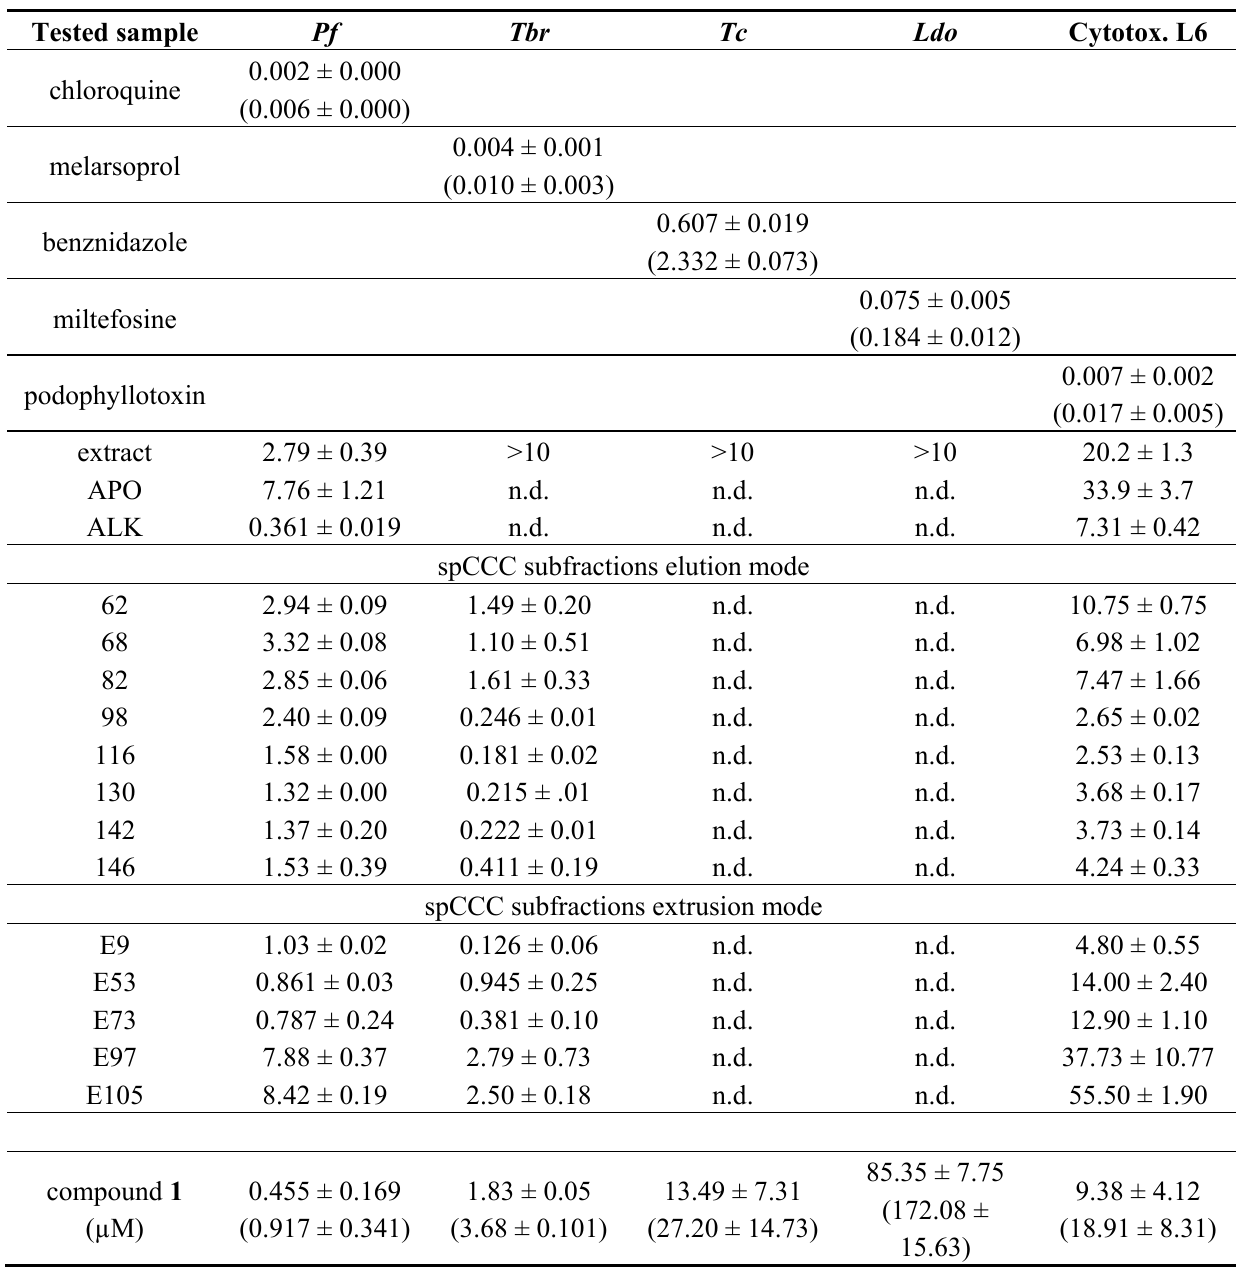
Table 1. IC values of B. sempervirens leaf extract, its fractions and subfractions as well 50 as isolated O -tigloylcyclovirobuxeine B ( 1 ). All data represent the mean of at least two independent determinations and are expressed in µg/mL, those for 1 and the positive controls also in µM (in